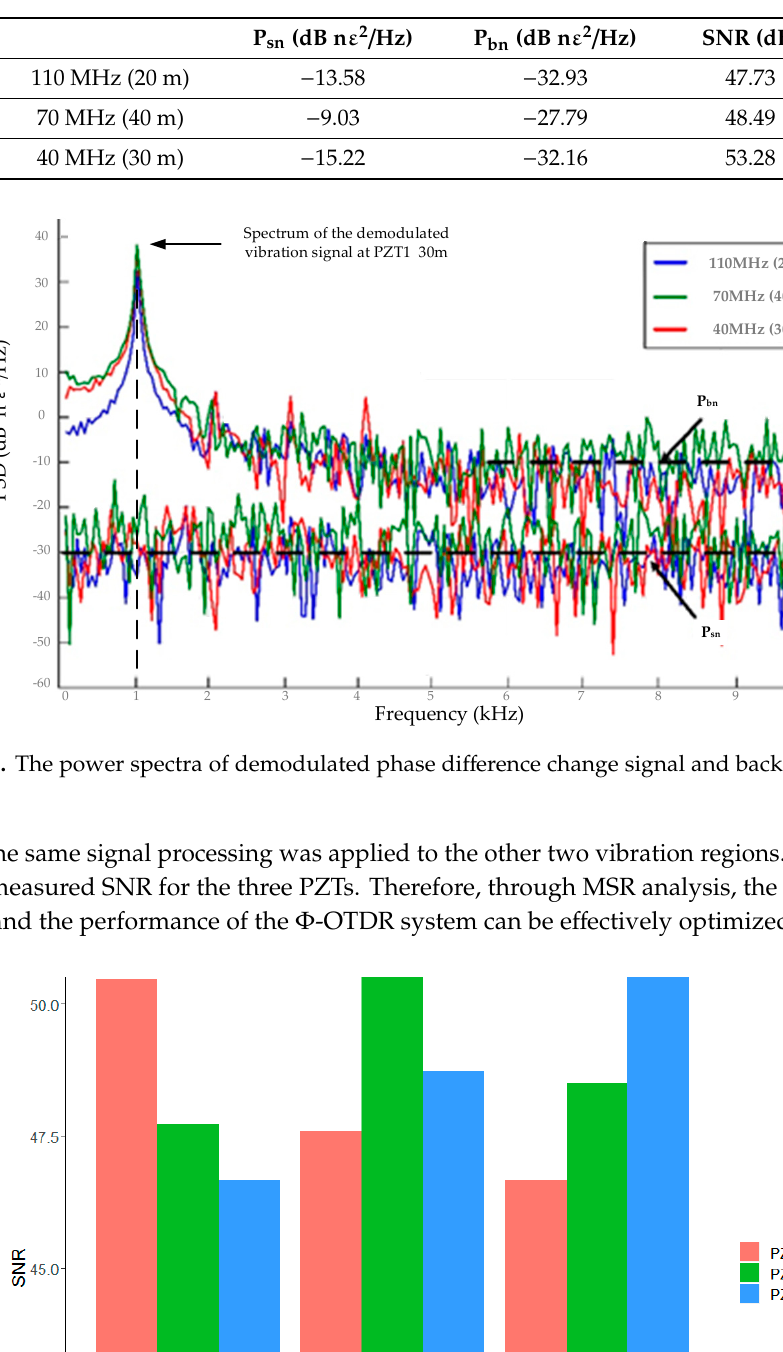
Table 1. Power spectra of demodulated signal PZT1 and background noise.